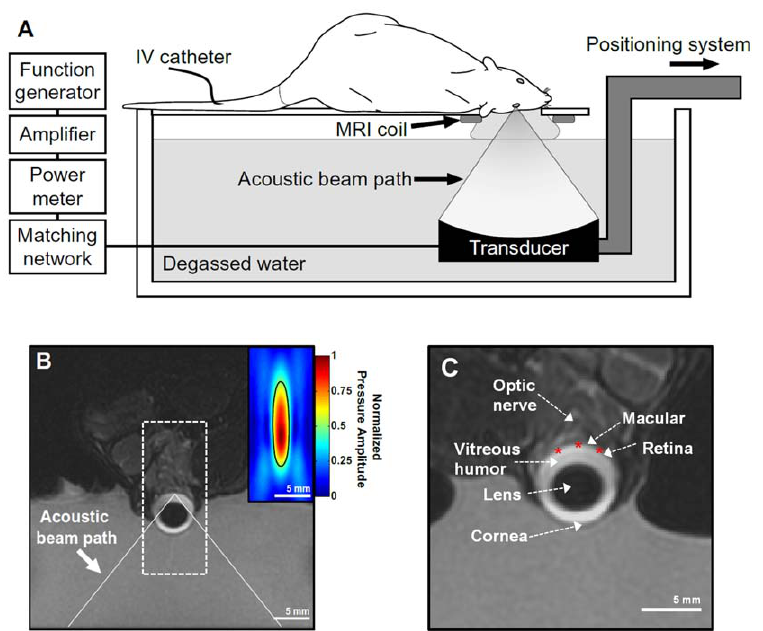
Figure 1. BRB disruption in the rat eye using an MRI-guided FUS system. ( A ) Schematic diagram of the experimental set up used to disrupt the BRB. ( B ) Coronal T2-weighted MR image of a rat eye within the sonication system. The eye was partially submerged in water to allow for acoustic coupling. The ultrasound beam path is superimposed. ( Inset ) Normalized focal pressure distribution of the focal region of the ultrasound beam (boxed region) displayed at the same scale as the MR image. ( C ) Relevant anatomical features of the eye visible in the MR image. The location of three of the five locations targeted for sonication are shown as star symbols. doi:10.1371/journal.pone.0042754.g001 PLOS ONE |